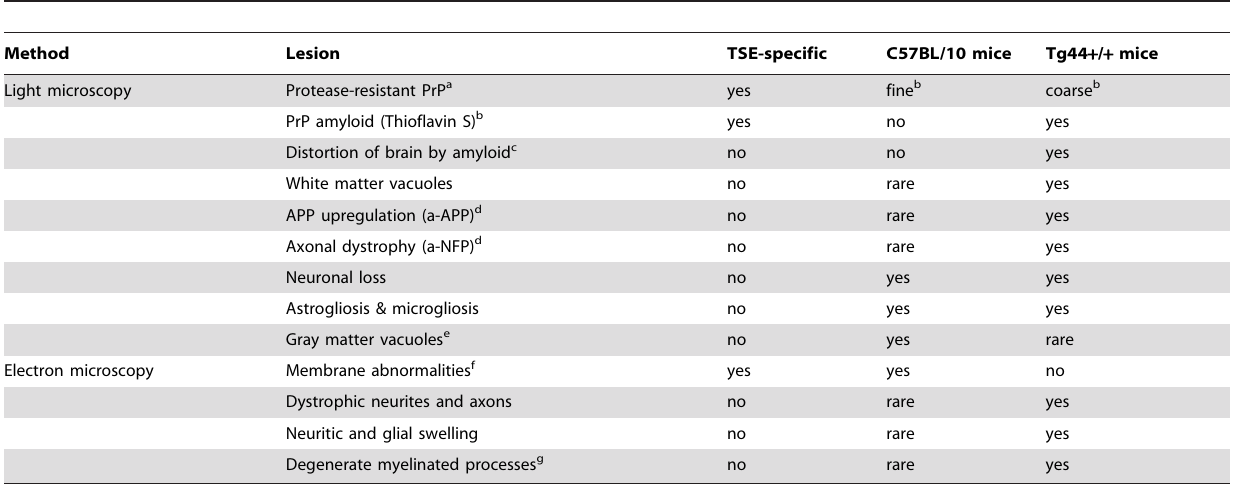
Table 3. Comparison of histopathological features in scrapie-infected C57BL/10 mice and homozygous anchorless PrP transgenic mice (tg44 + / +